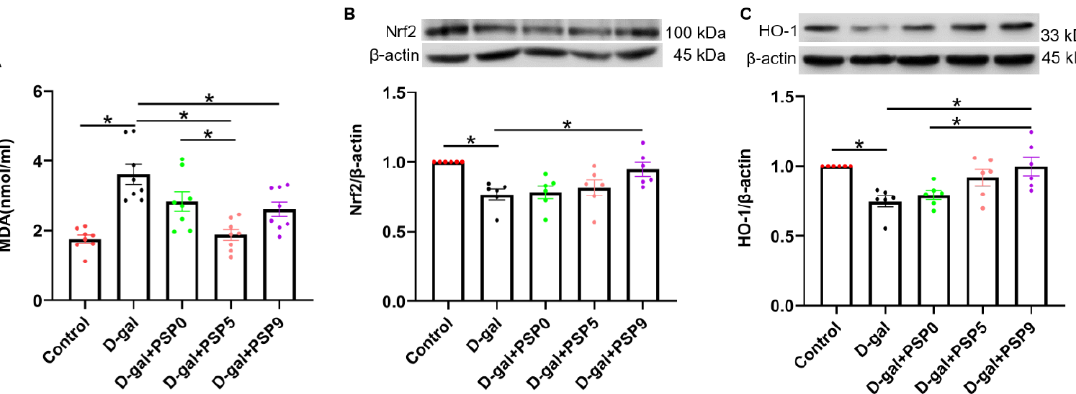
Figure 5. Steamed PSPs attenuate D-gal-induced oxidative damage by regulating the HO-1/Nrf2 signaling pathway. ( A ) MDA level in the serum ( n = 8). ( B , C ) The upper panels show representative blots of Nrf2/ β -actin and HO-1/ β -actin, while the lower panel shows Nrf2/ β -actin and HO-1/ β -actin quantification data ( n = 6). Data are expressed as means ± SEM. * p < 0.05.